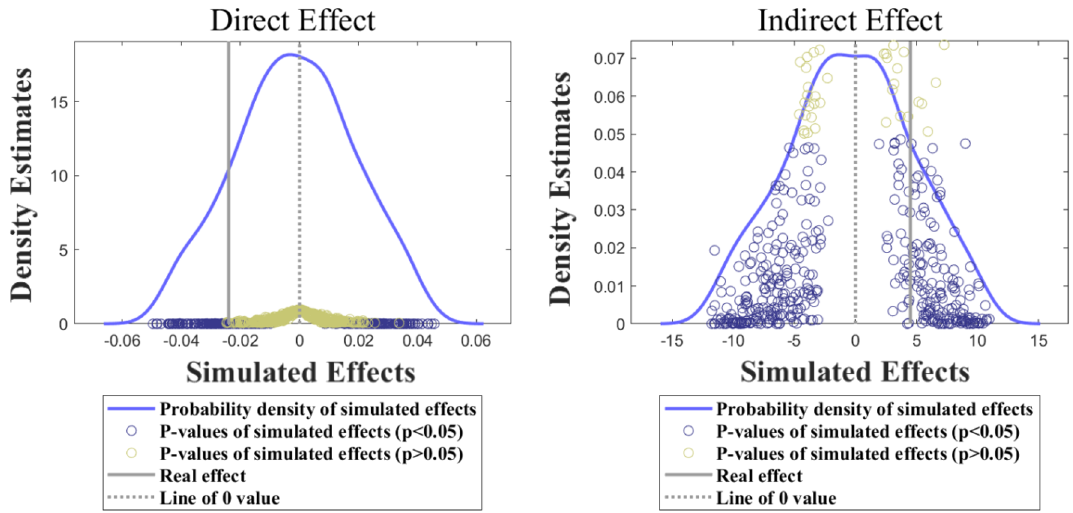
Figure 3. Placebo test